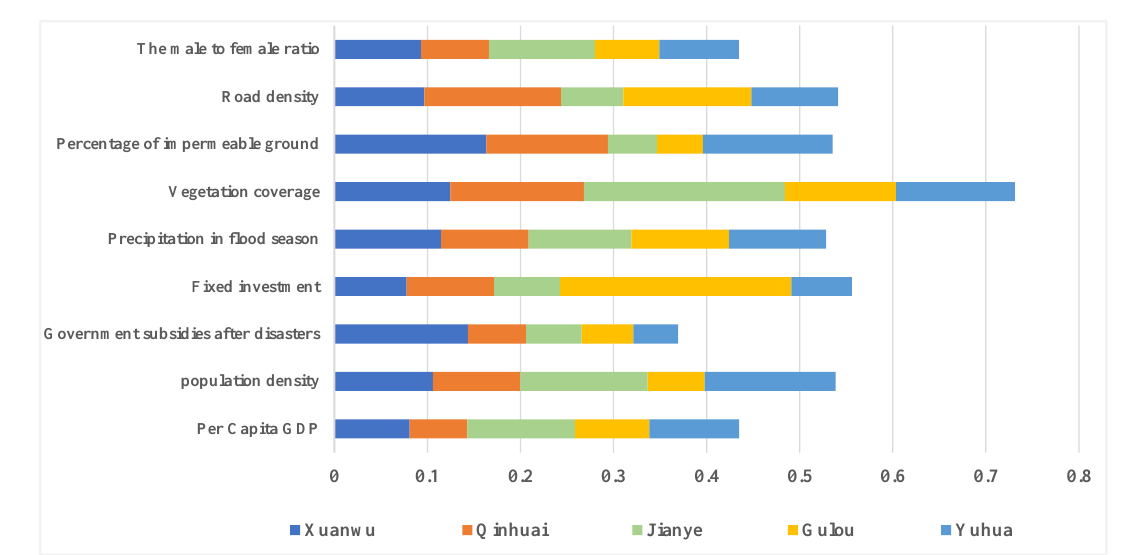
Figure 5. The contribution of indicators to urban flood.